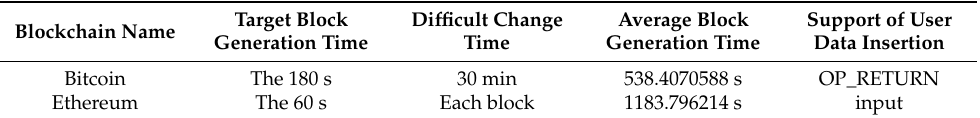
Table 1. Block generation time result of each blockchain.